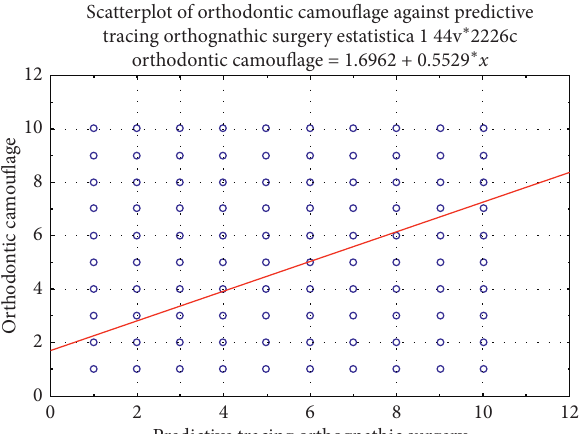
Figure 5: Scatterplot of the scores of facial profile attractiveness of predictive tracing of orthognathic surgery and orthodontic camouflage. Table 3: Comparison of profile attractiveness scores between laypeople and dentists (Mann–Whitney test). Laypeople Dentists N � 987 N � 1260 Score of profile attractiveness Median (mean) SD (range) Median (mean) SD (range) Predictive tracing of orthognathic surgery Orthodontic